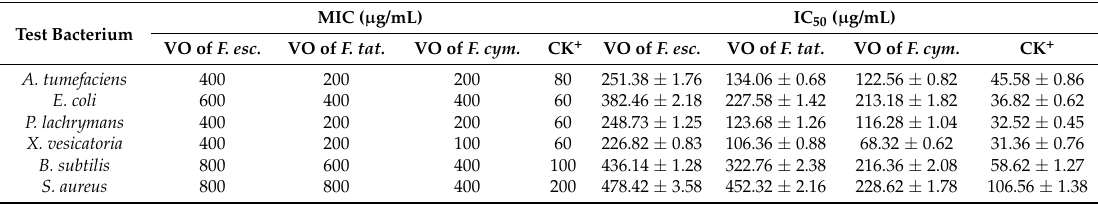
Table 3. Antimicrobial activity of the volatile oils of three buckwheat